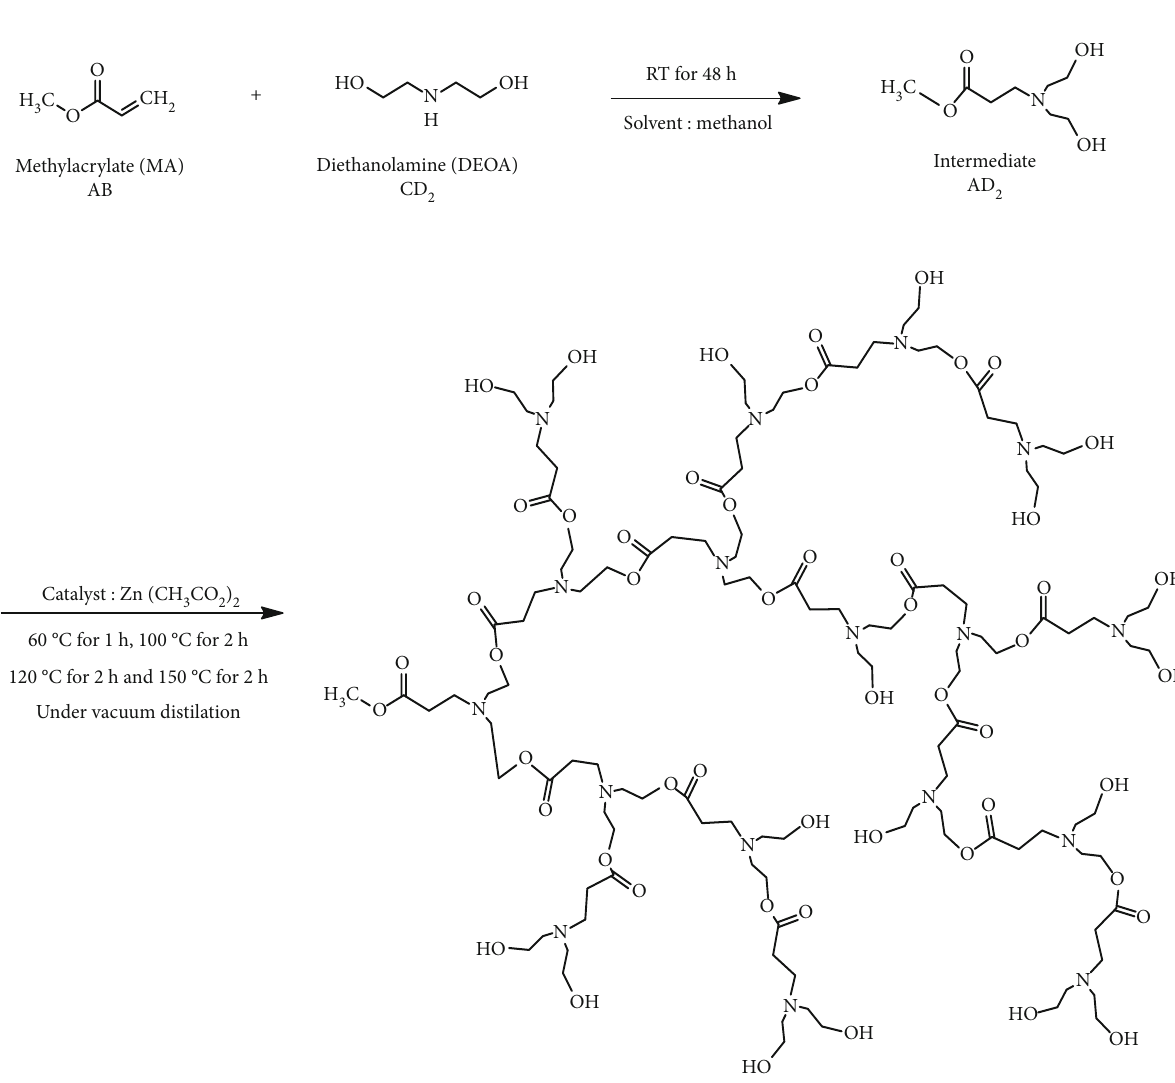
Scheme 1: Synthetic route of hyperbranched poly(MA-DEA)